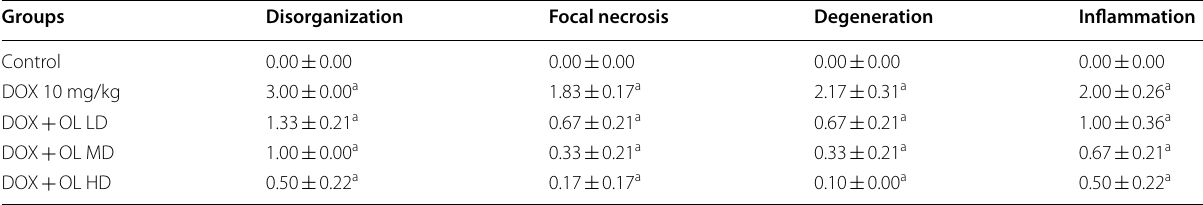
Effect of DOX and OL on histopathological changes in cardiac tissues. Severity of injury is depicted as mean P < 0.05 versus DOX group. Grade 1 < 5% mild. Grade 2